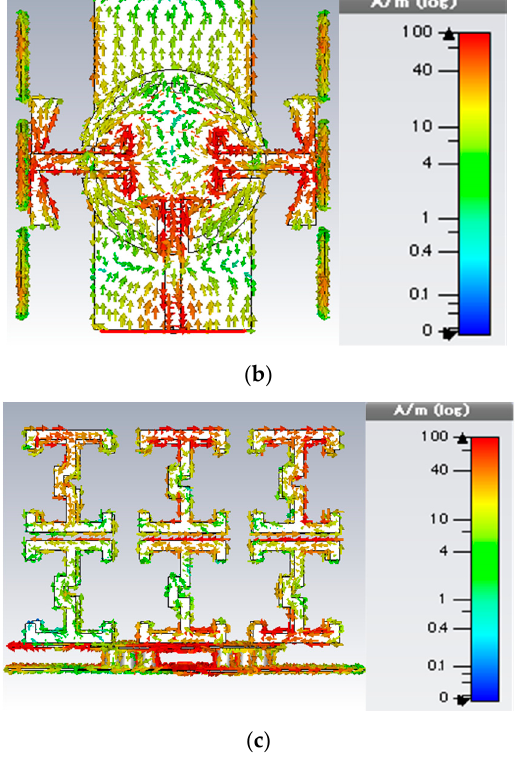
Figure 11. Current distribution. ( a ) Current distribution on an antenna without ENZ unit cells ( b ) Current distribution on the antenna with ENZ unit cells ( c ) Current distribution on the ENZ unit cells.